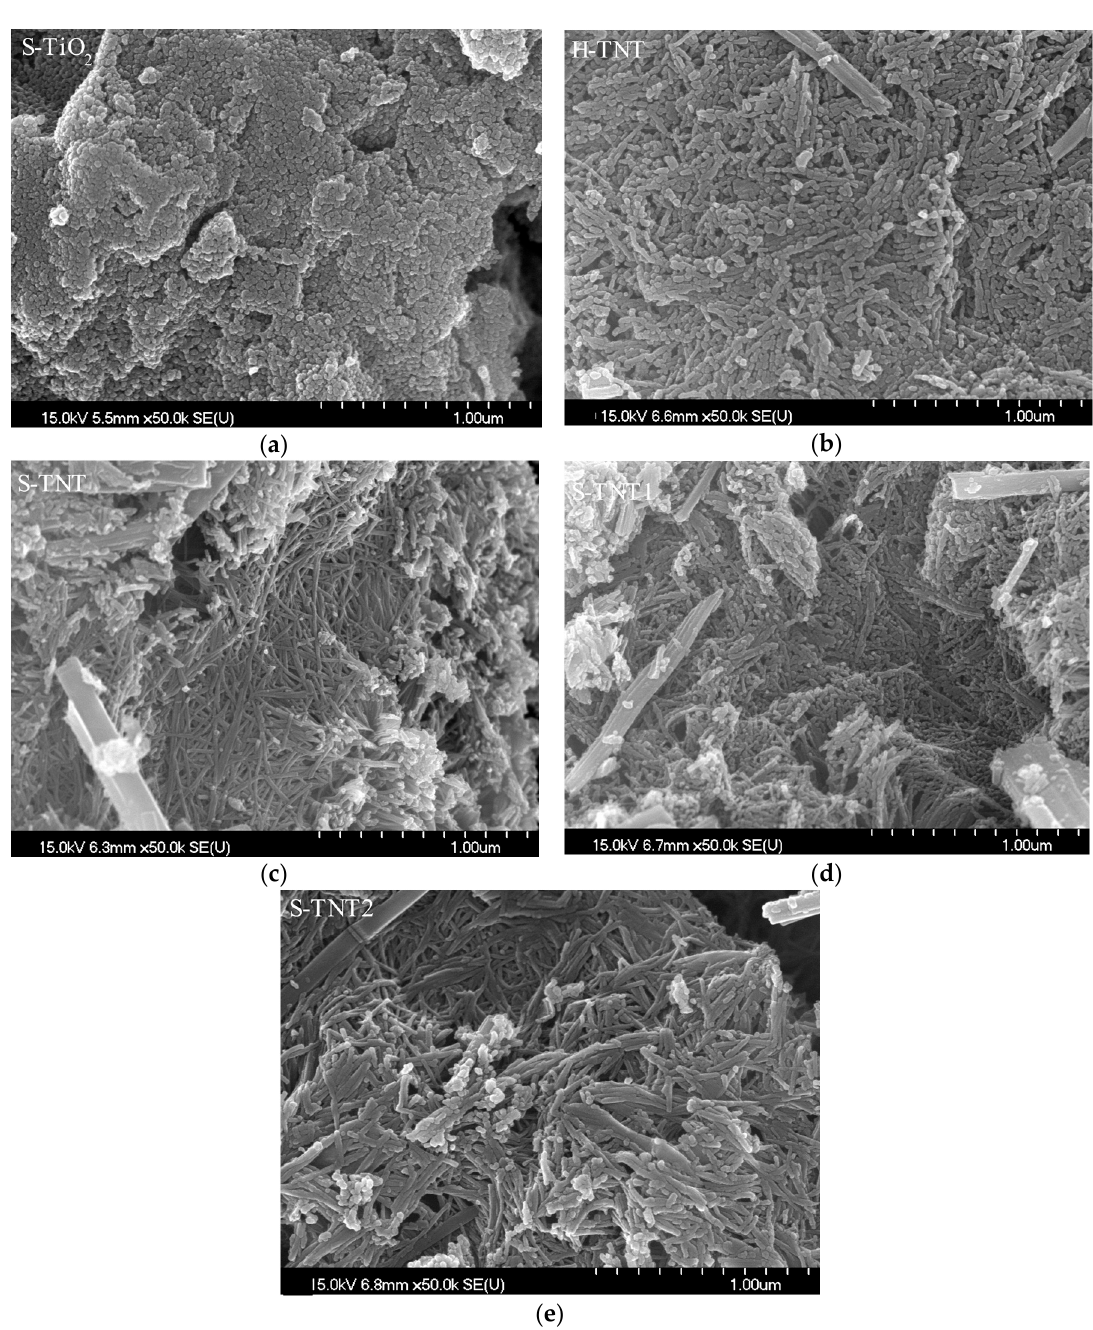
Figure 2. Scanning electron microscope (SEM) images of ( a ) S-TiO 2 , ( b ) H-TNT, ( c ) S-TNT, ( d ) S-TNT1, and ( e ) S-TNT2.